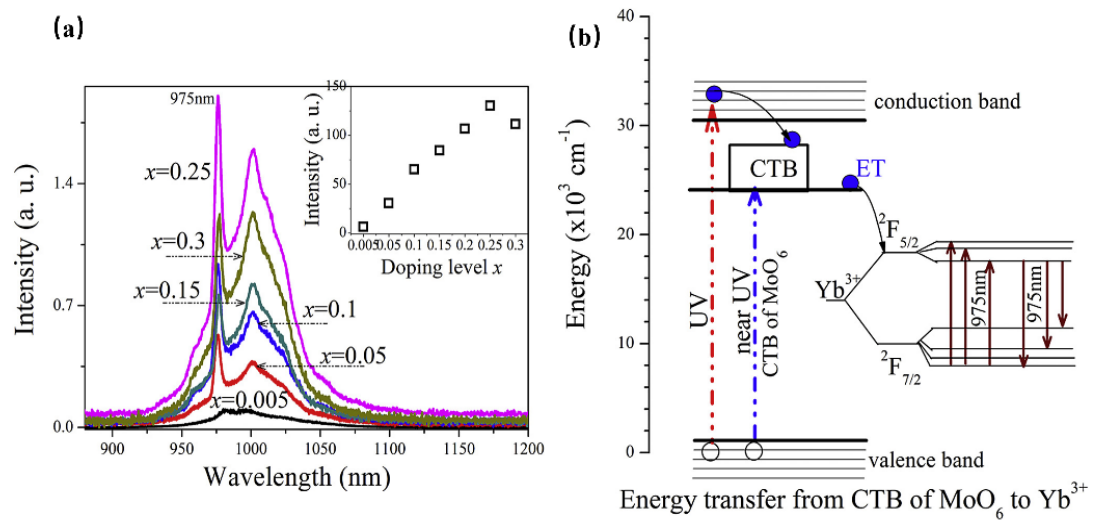
Figure 2. ( a ) The PL spectra of Y 4 − x Yb x CdMo 3 O 16 (x = 0–0.3) phosphors (Ex = 400 nm and Em = 980 nm). ( b ) The scheme of the suggested energy transfer from the Y 4 CdMo 3 O 16 host to the Yb 3+